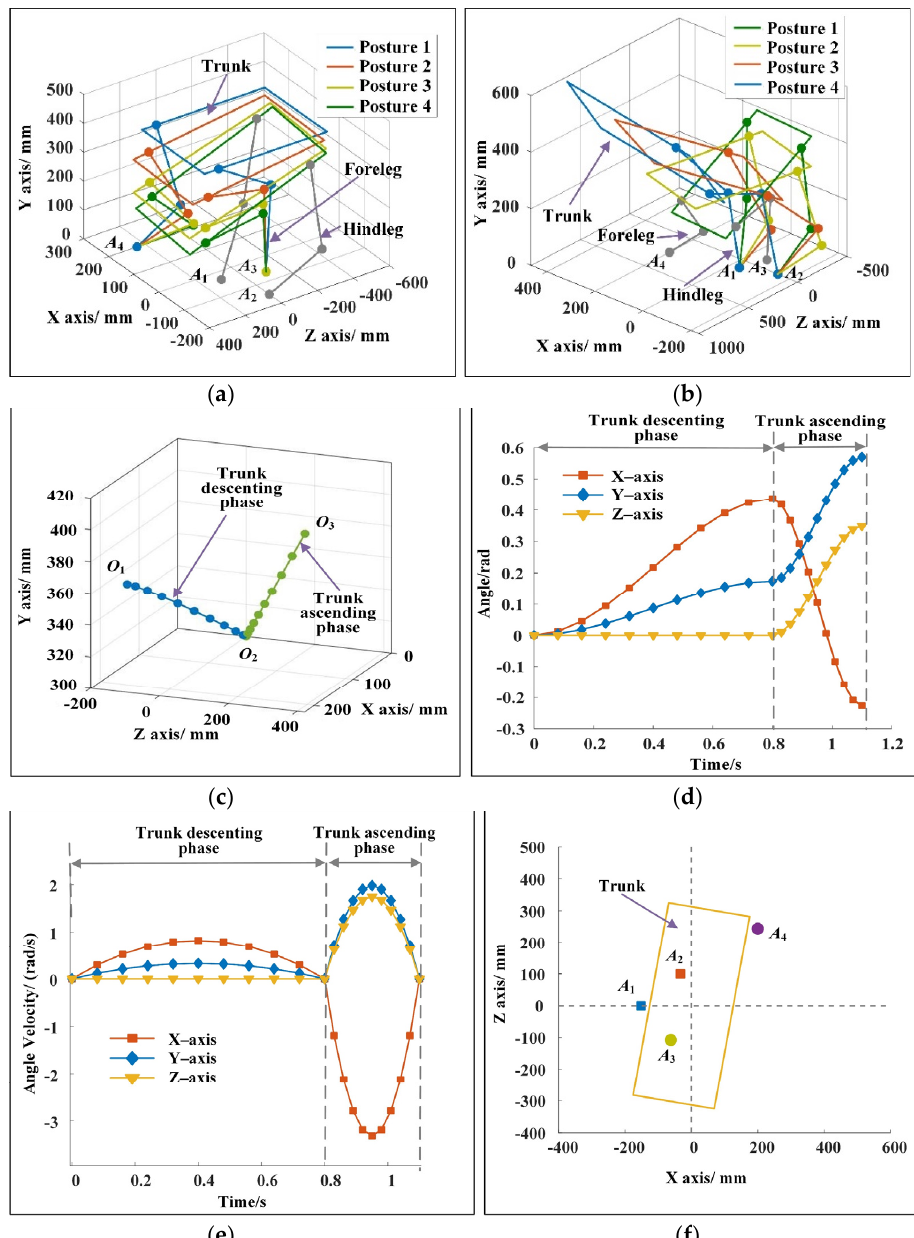
Figure 3. ( a ) Motion sequence of the robot in the descending phase of the trunk for example 1. ( b ) Motion sequence of the robot in the ascending phase of the trunk for example 1. ( c ) Movement trajectory of the trunk for example 1. In the descending and ascending phases of the trunk, the trajectories are cubic functions. ( d ) Changes of trunk posture for example 1. In the descending phase of the trunk, the angle changes of the trunk around the three axes are 25 ◦ , 10 ◦ , and 0 ◦ . In the ascending phase of the trunk, the angle changes of the trunk around the three axes are 38.01 ◦ , − 22.69 ◦ , and − 20.00 ◦ . ( e ) Changes of trunk angular velocity for example 1. The angular velocity of the robot at the moment of leaving the ground is zero. ( f ) Landing points of the forelegs and the hindlegs for example